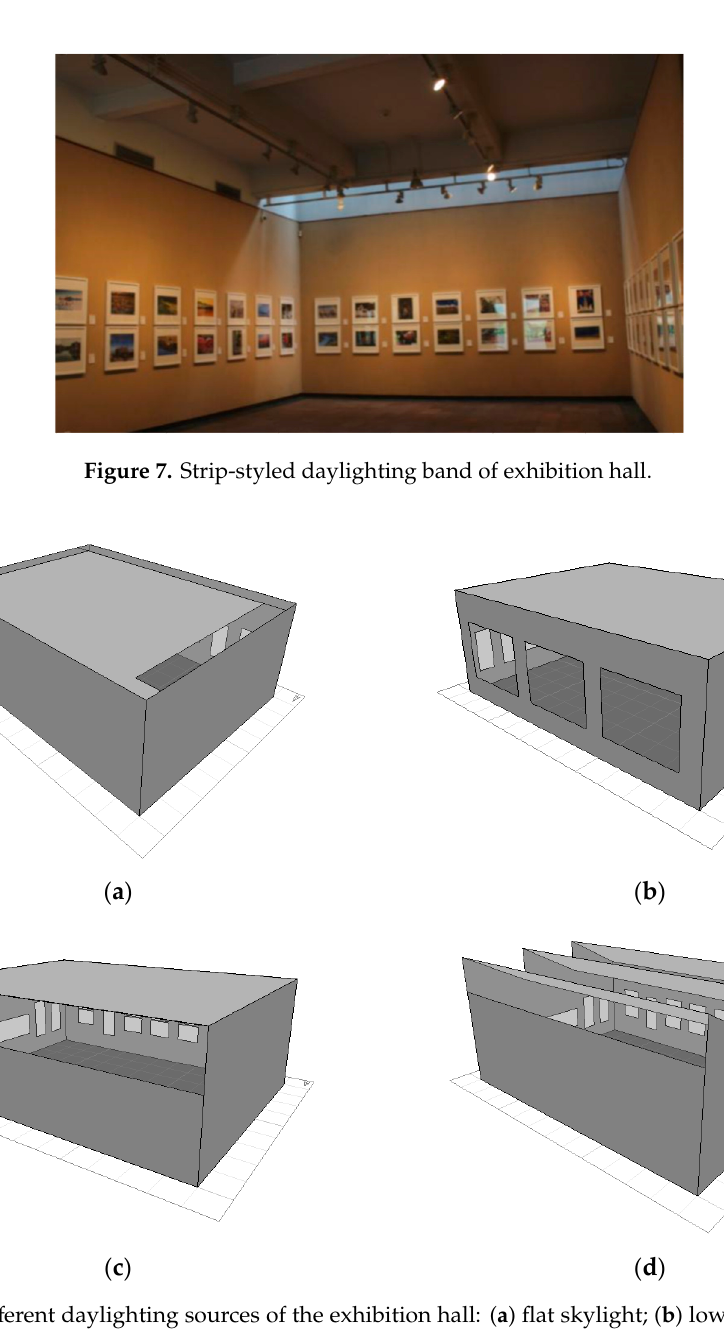
Figure 8. Different daylighting sources of the exhibition hall: ( a ) flat skylight; ( b ) low side window; ( c ) high side window; ( d ) sawtooth skylight. Table 1. Daylighting opening parameters of the hanging display under various window conditions.